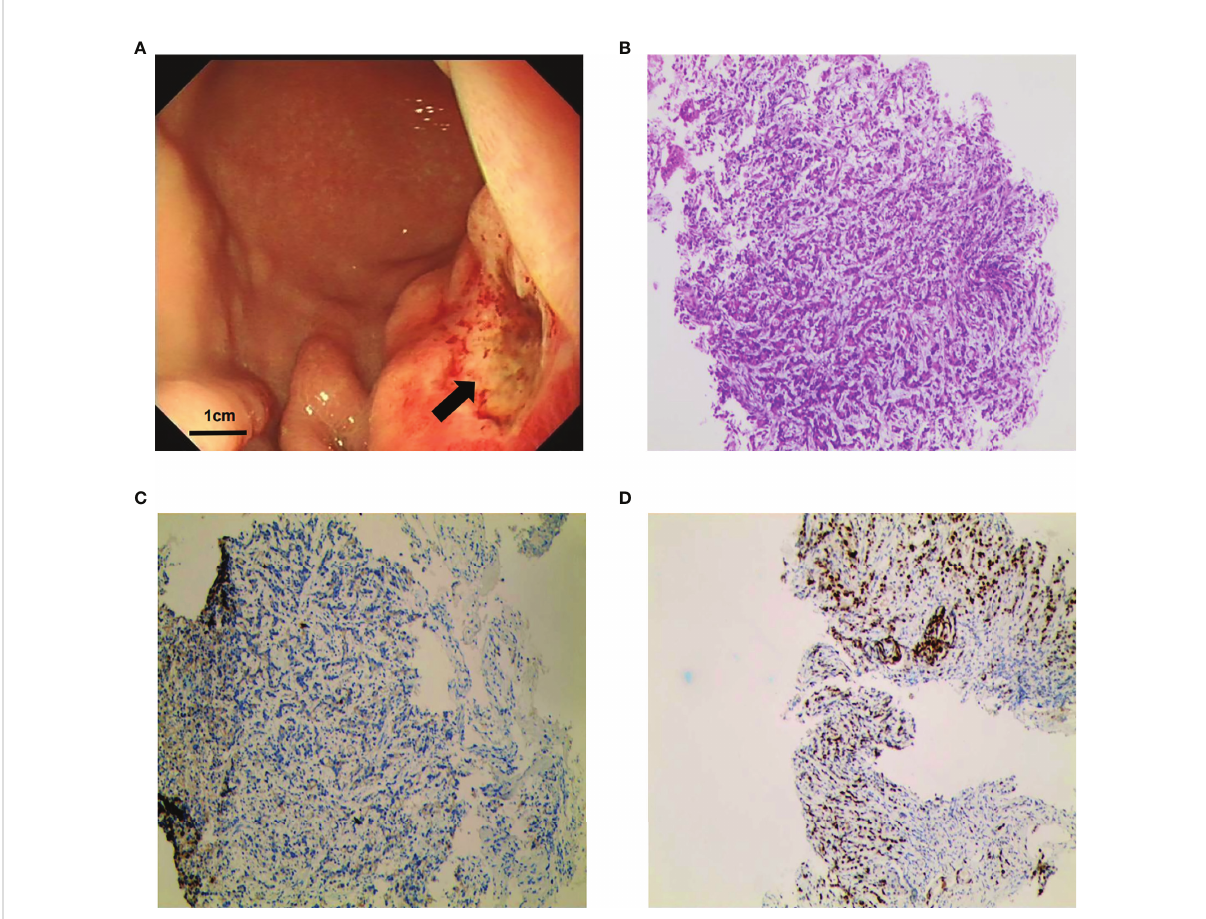
FIGURE 3 Gastroscopy and gastric biopsy pathology results. (A) Image of gastroscopy results, showing a tumor located at the body of the stomach (as indicated by the arrows). (B) Histopathological examination revealed poorly differentiated gastric adenocarcinoma (hematoxylin and eosin staining; magni fi cation, ×100). (C) Negative staining for HER2 (magni fi cation, ×100). (D) Positive staining for Mut L homolog 1 (MLH1) (magni fi cation,